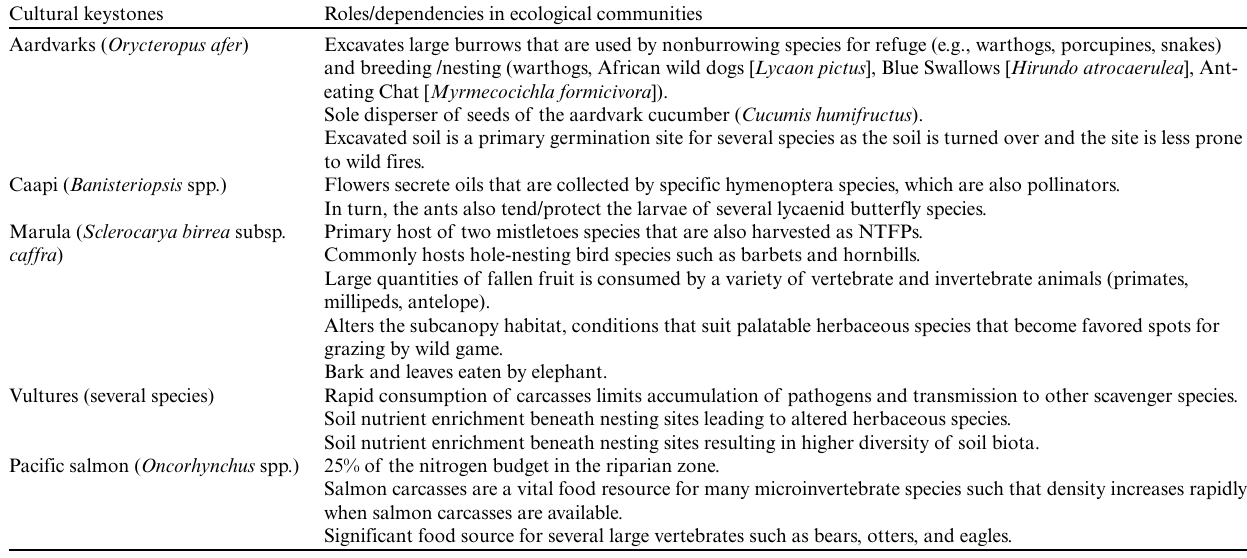
Table 1 . Examples of cultural keystones across a range of taxa with multiple roles or links in their ecological community. Cultural keystones Roles/dependencies in ecological communities Aardvarks ( Orycteropus afer ) Excavates large burrows that are used by nonburrowing species for refuge (e.g., warthogs, porcupines, snakes) and breeding /nesting (warthogs, African wild dogs [ Lycaon pictus ], Blue Swallows [ Hirundo atrocaerulea ], Ant- eating Chat [ Myrmecocichla formicivora ]). Sole disperser of seeds of the aardvark cucumber ( Cucumis humifructus ). Excavated soil is a primary germination site for several species as the soil is turned over and the site is less prone to wild fires. Caapi ( Banisteriopsis